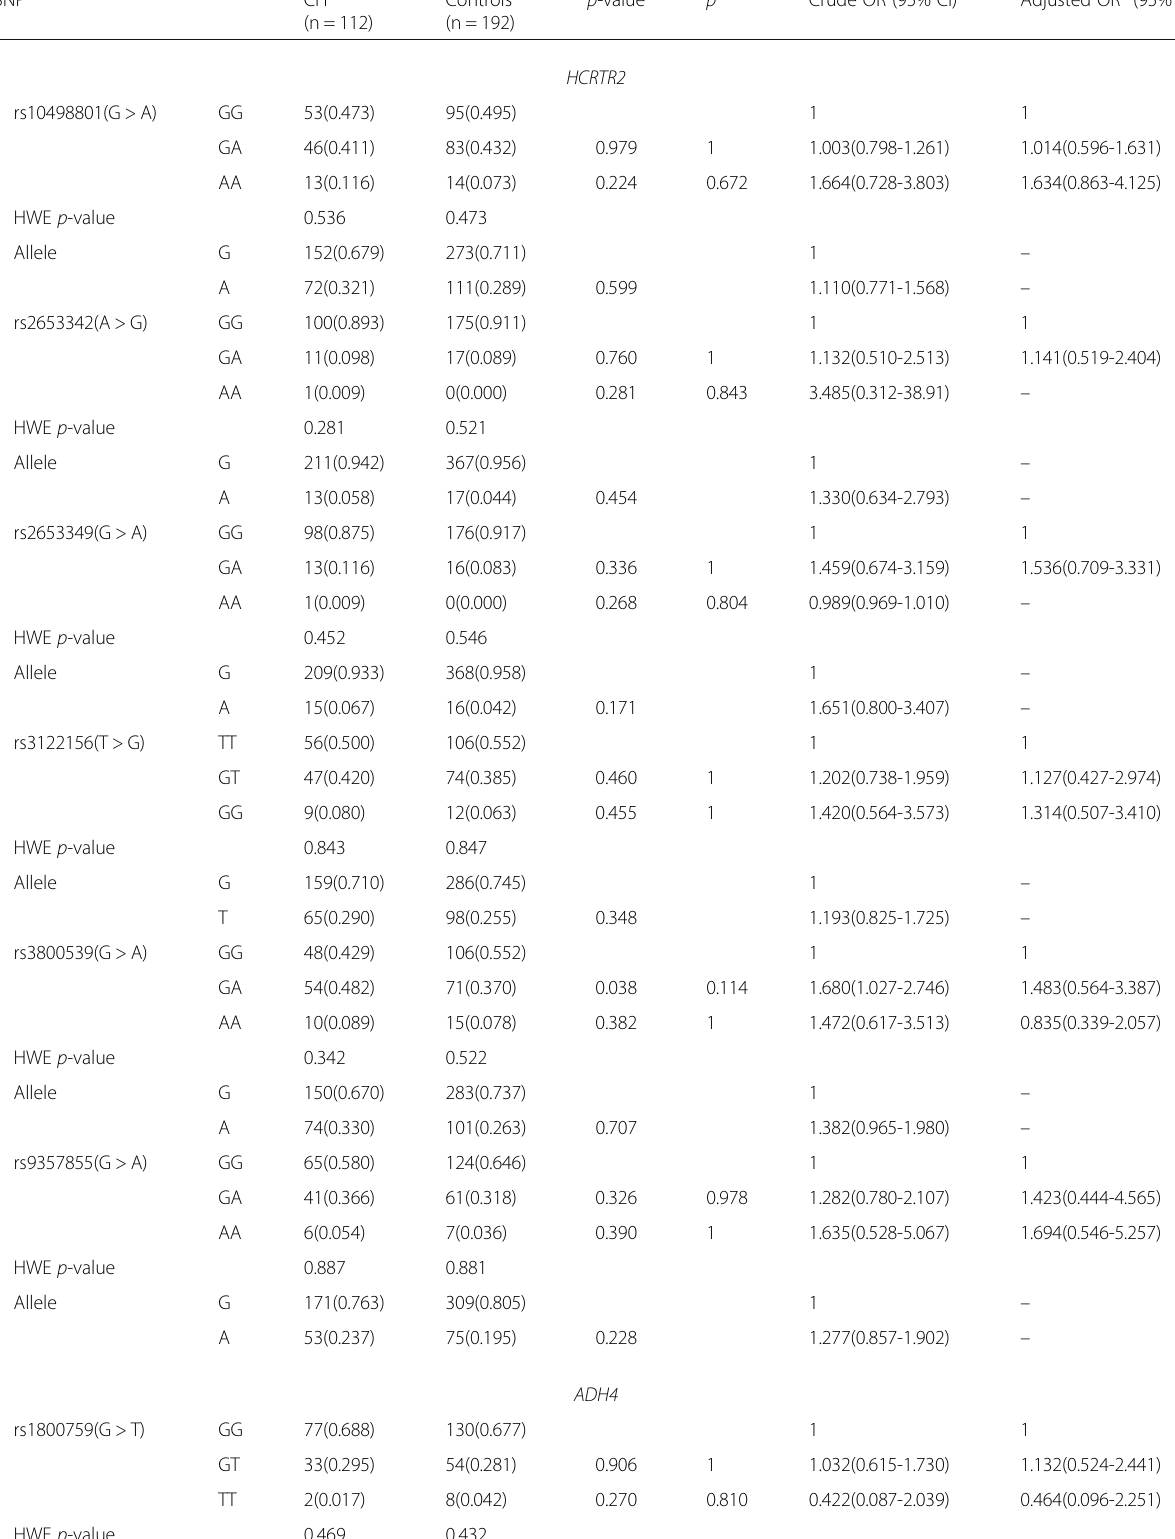
Table 2 Genotype and allele frequency of the polymorphisms between cases and